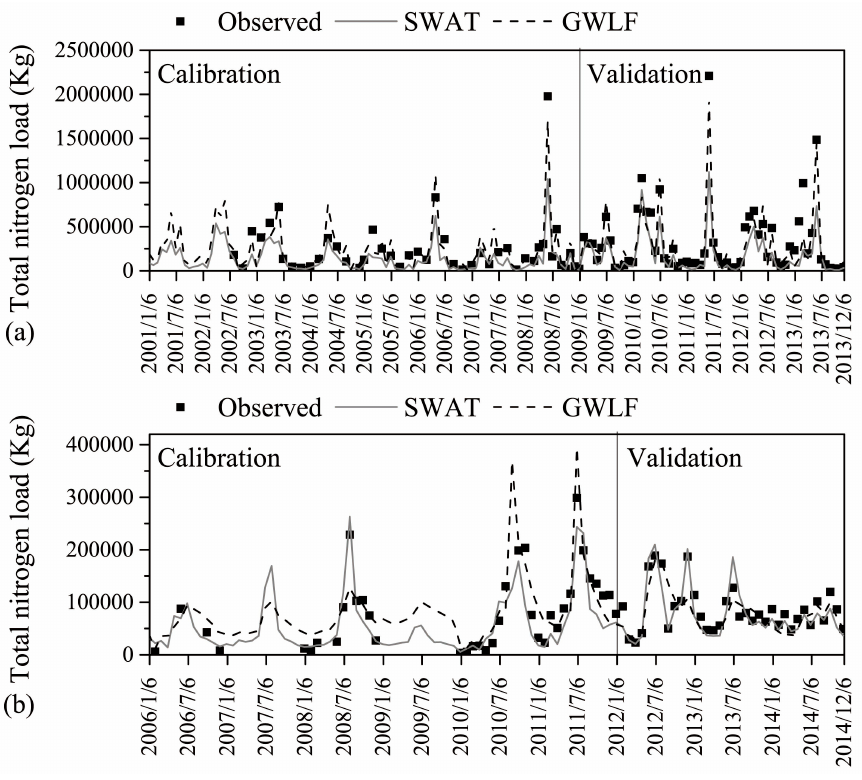
Figure 5. Simulated and observed monthly total nitrogen for the: ( a ) Tunxi watershed; and ( b ) Hanjiaying watershed.